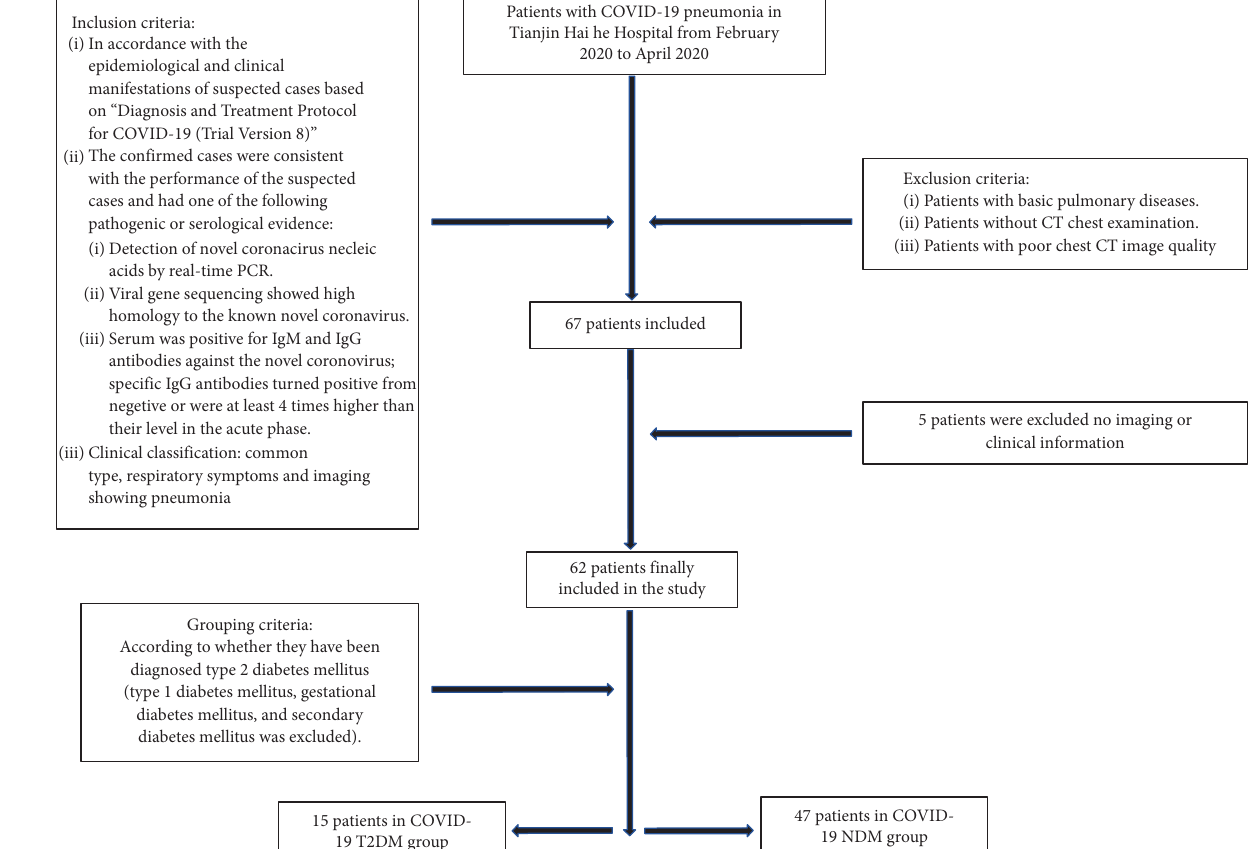
15 patients in COVID- 19 T2DM group Figure 1: The inclusion and exclusion criteria of the